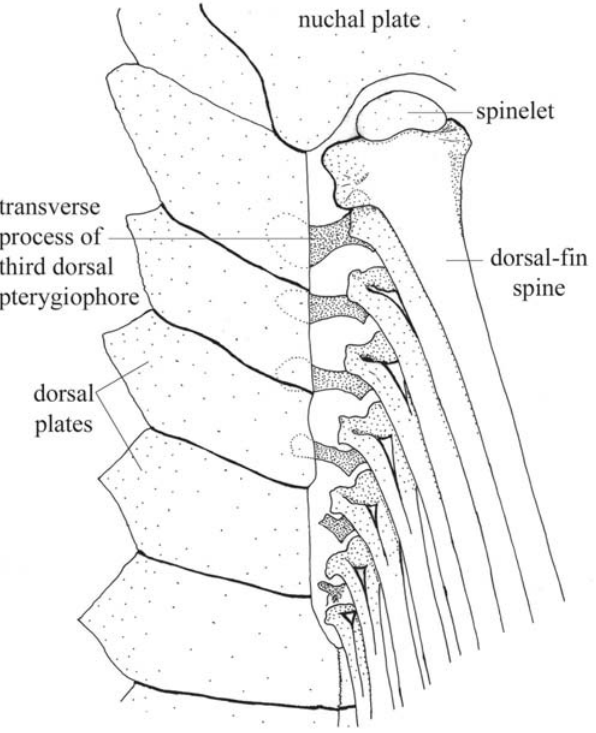
Fig. 44. Dorsolateral view of the dorsal-fin of Lamontichthys stibaros (FMNH 84111, 62.4 mm SL). Cartilages not represented. Scale bar = 1